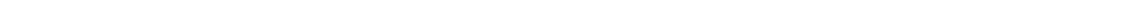
Fig. 1 MZ B cells couple increased TACI expression with enhanced mTORC1 signaling. a Transmission electron microscopy of human splenic follicular